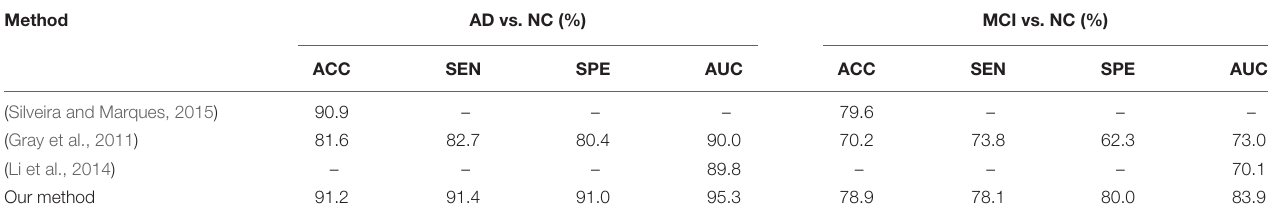
TABLE 5 | Comparison of the classification performances reported in the